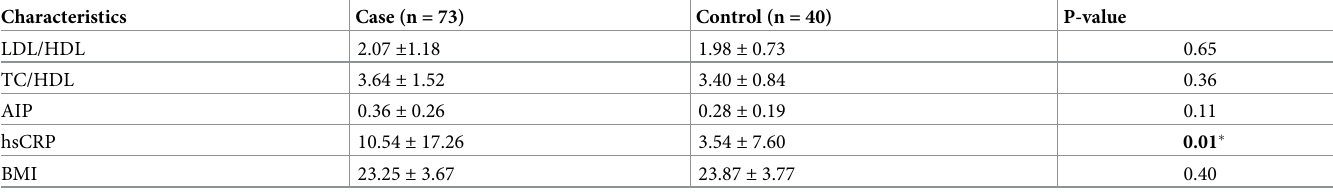
(AIP; Atherogenic index of plasma, BMI; Body mass index, HDL; high density lipoprotein, hsCRP; high sensitivity C-reactive protein, LDL; low density lipoprotein, TC; total cholesterol; � indicates P <